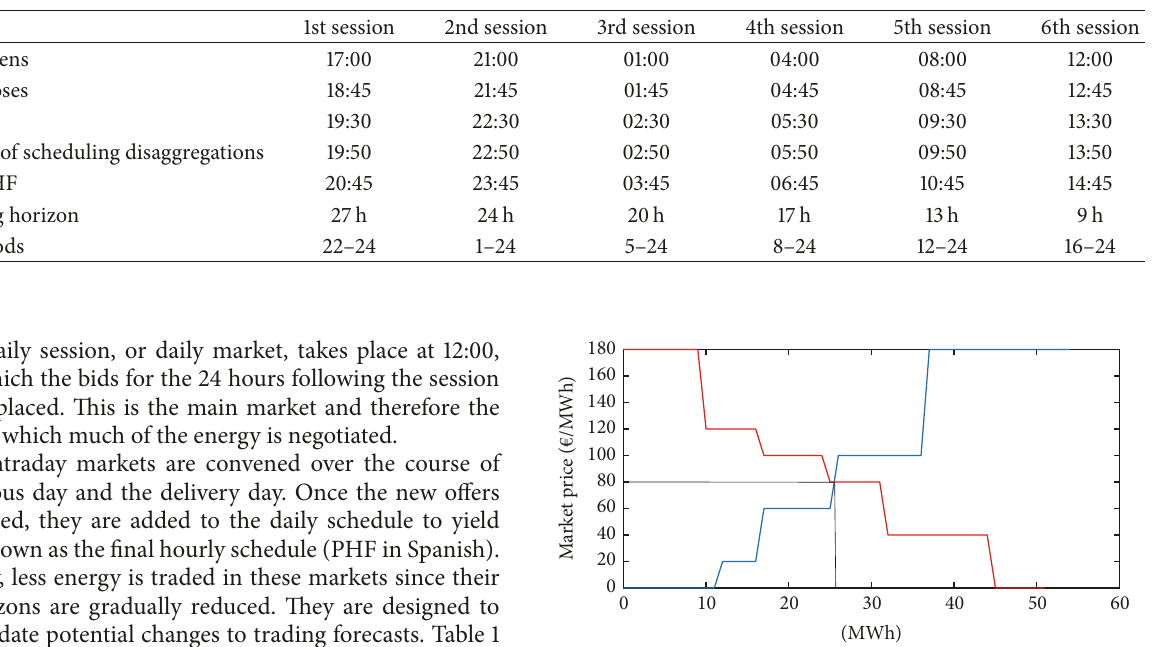
Table 1: Hours of operation for intraday market sessions.